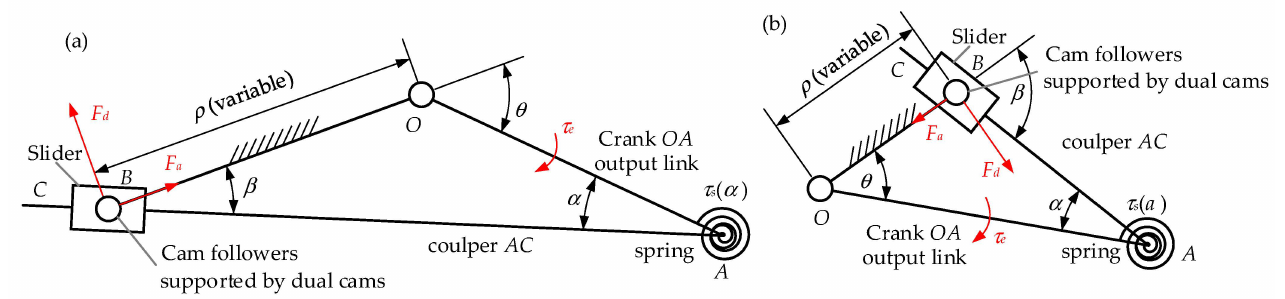
Figure 4. Two reconfigurable configurations ( a ) Configuration I: low stiffness with limited range ( AB > OA ); ( b ) Configuration II: infinite stiffness range ( AB < OA